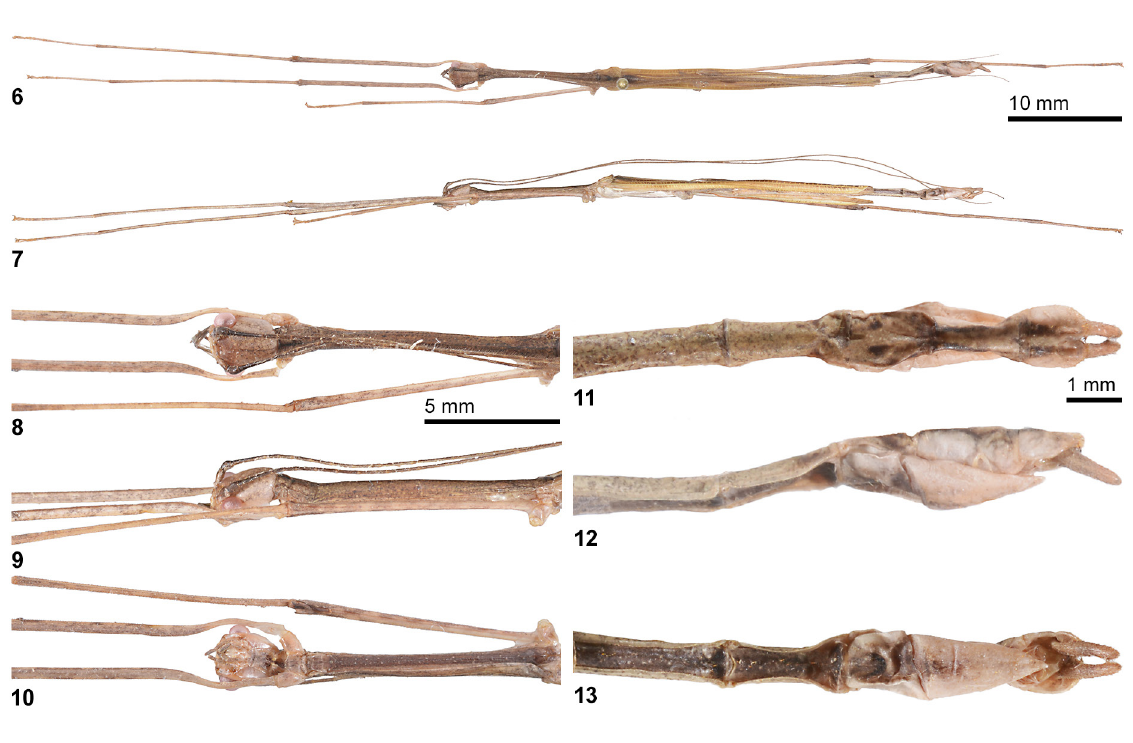
Figs 6–13. Phantasca adiposa sp. nov. Paratype, ♂. 6 . Habitus, dorsal view. 7 . Habitus, lateral view. 8 . Head, pro- and mesothorax, dorsal view. 9 . Head, pro- and mesothorax, lateral view. 10 . Head, pro- and mesothorax, ventral view. 11 . Apex of abdomen, dorsal view. 12 . Apex of abdomen, lateral view. 13 . Apex of abdomen, ventral